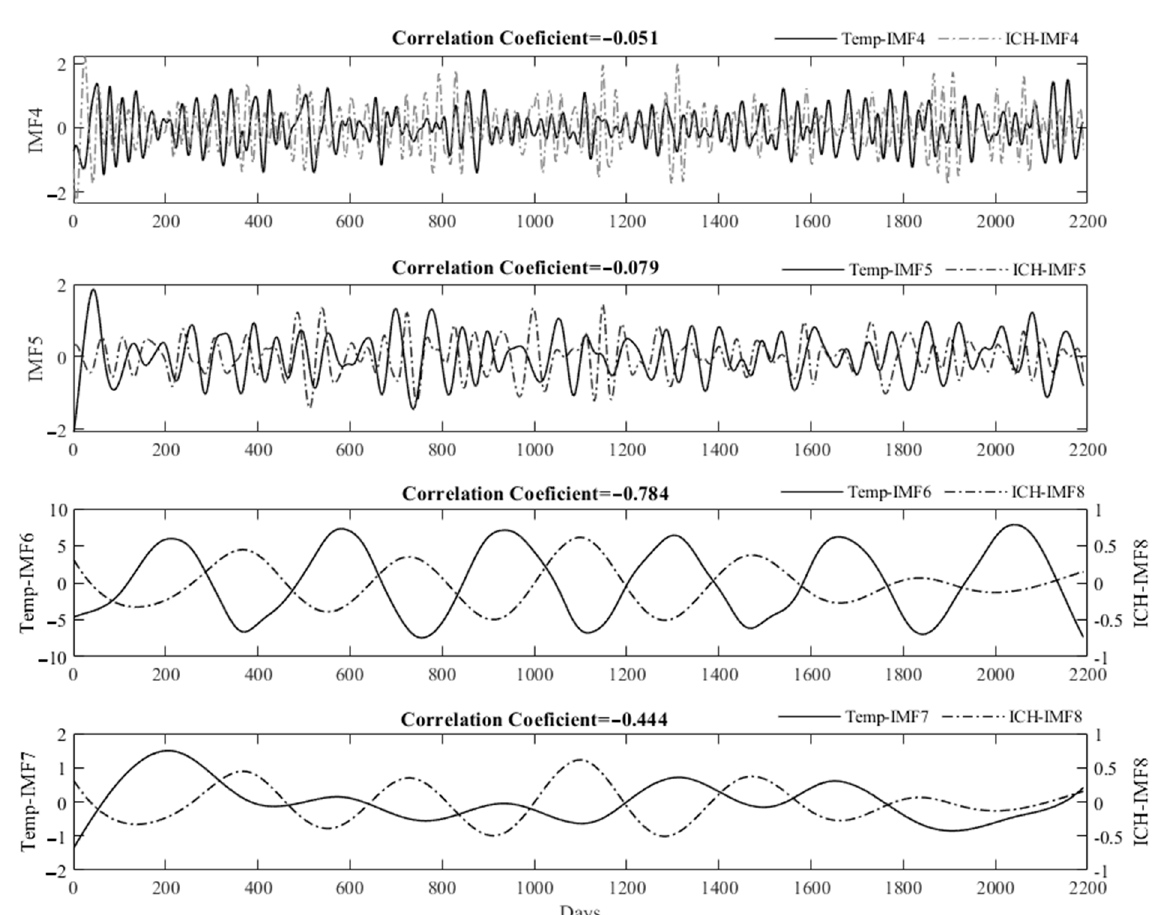
Figure 5. Spearman’s rank correlation coefficients between relevant IMFs of daily events of ICH and mean temperatures and in the elderly group in Taipei Area. Table 4. Spearman’s rank correlation coefficients between the IMFs of temperature and the IMFs of stroke events with similar period intervals in Kaohsiung City and Taipei Area.